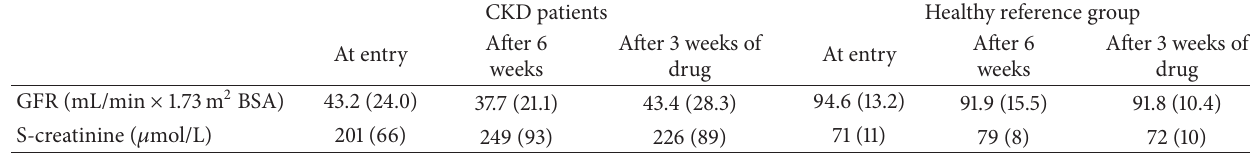
Table 6: Glomerular filtration rate and serum creatinine at entry, after administration of 1mg tesaglitazar for 6 weeks, and at followup 3 weeks after drug administration. Mean and standard deviation (in parenthesis).